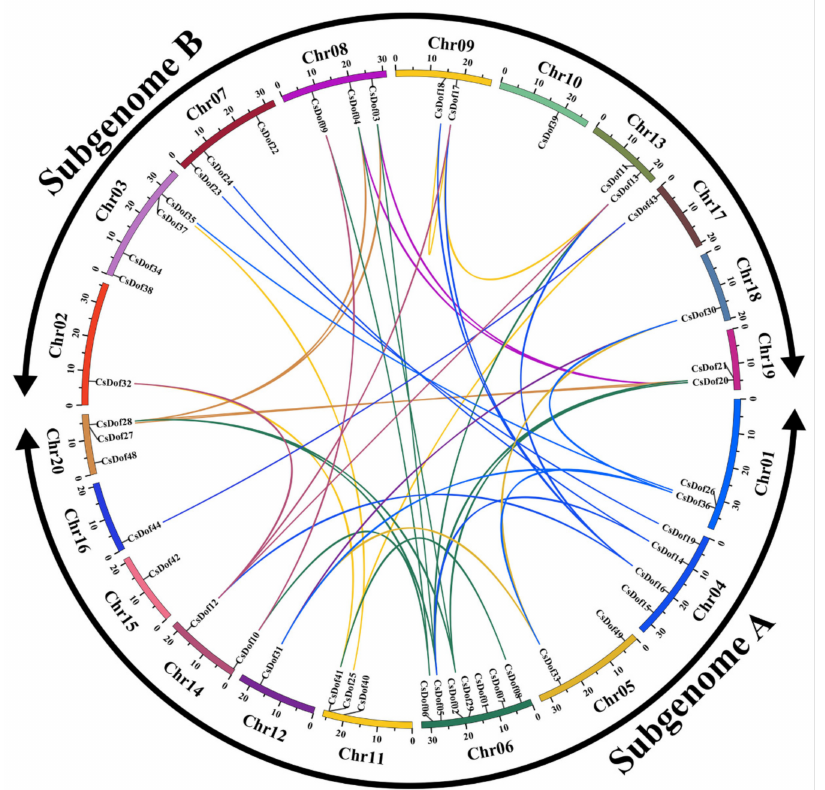
Figure 2. Distribution of the CsDof duplicated genes in C. songorica. The colored lines within the chromosomes represent the syntentic relationships in C. songorica Dof